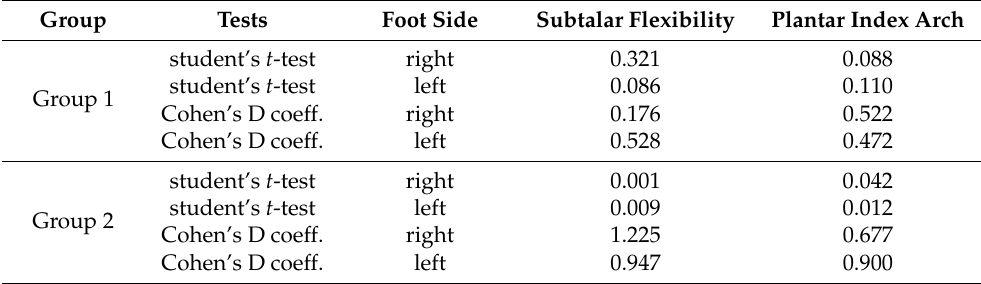
Table 5. p value (student’s t -test) * and Cohen’s D coefficient ** comparing the results between EV1 and EV2.